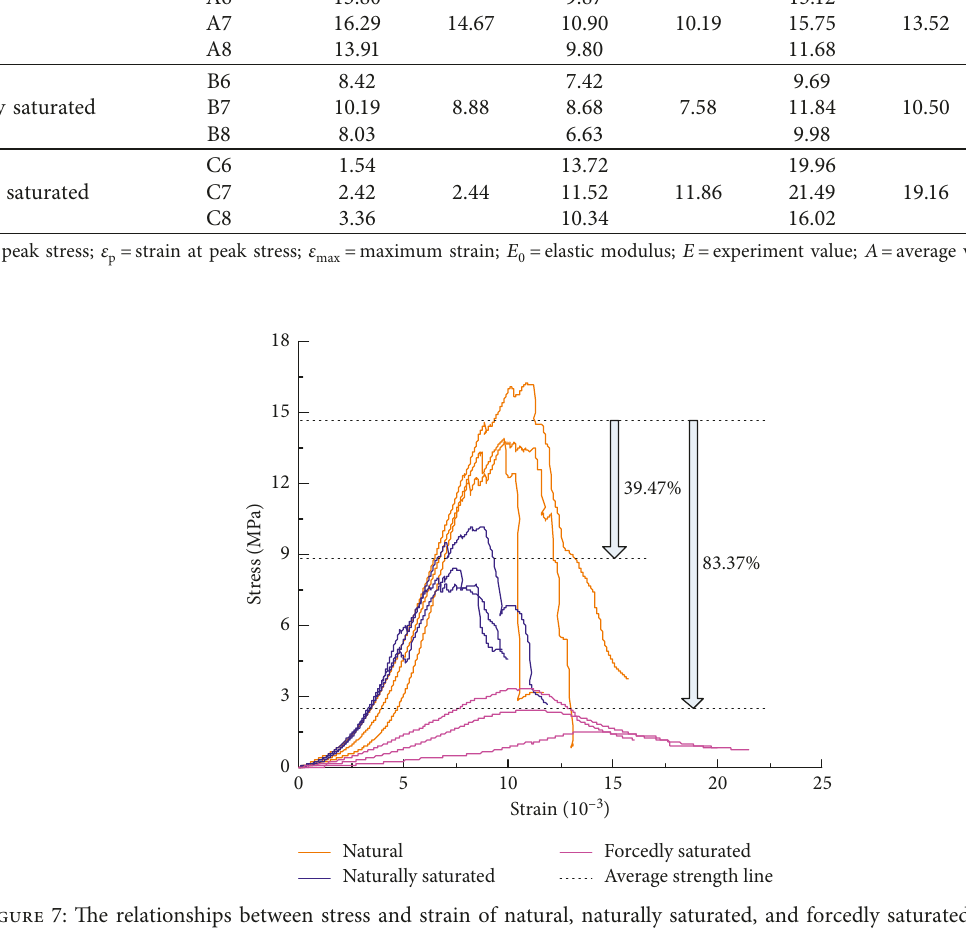
Table 4: The UCS test results of natural, naturally saturated, and forcedly saturated coal samples. Type of coal sample